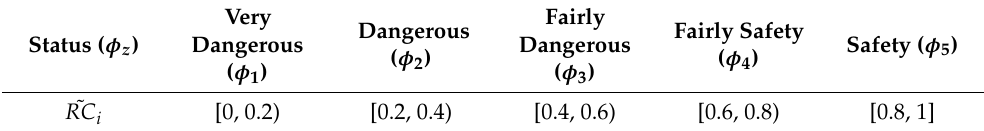
Table 2. Status of early warning objects related to fuzzy relative